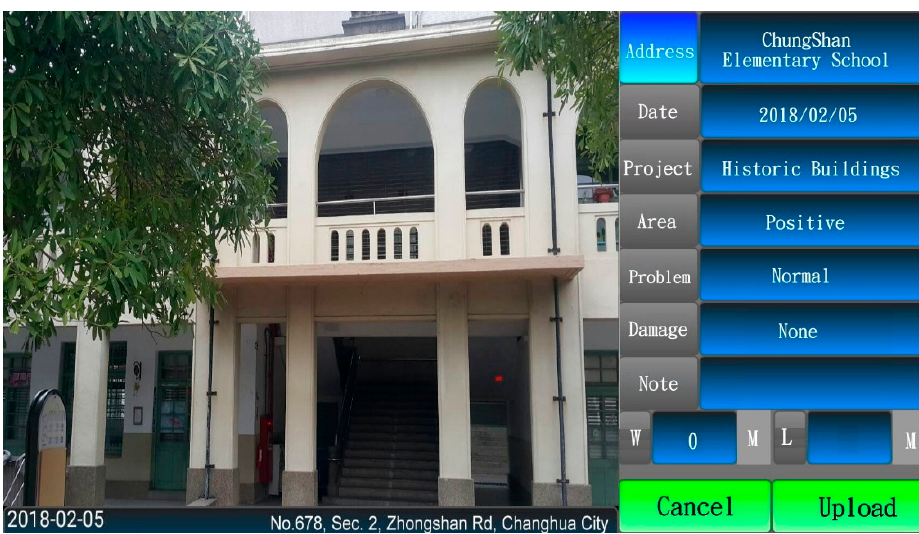
Figure 14. Filling in related information before uploading the image.